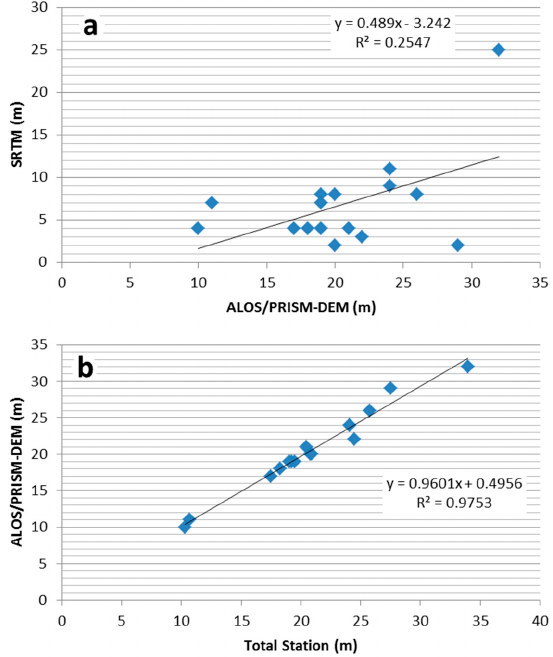
Figure 12. Comparison of elevation values obtained from satellite derived DEMs at 16 GCPs; ( a ) SRTM vs. ALOS/PRISM; and ( b ) ALOS/PRISM vs. total station measurements.